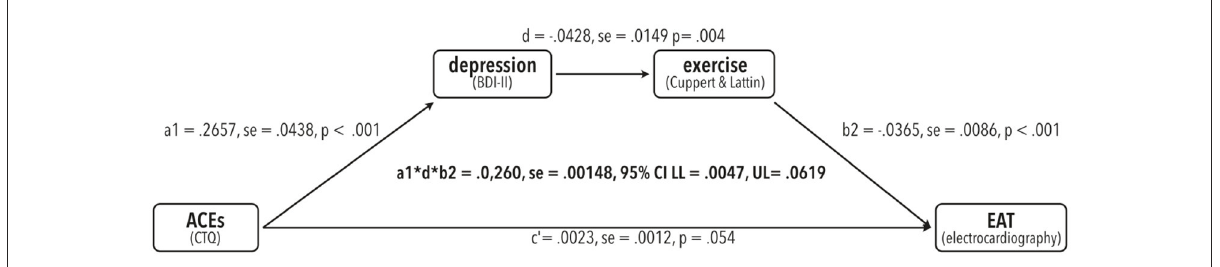
FIGURE2 Results from the testing the serial mediation model (model number 6) proposed in Figure 1 using bias-corrected bootstrapping with 10,000 resamples in PROCESS for R V4.0.1 with a 95% confidence interval (CI). Unstandardized regression coefficients are shown with the corresponding se (standard error) as well as t-values and p -values per path. Indirect effect statistics are shown in the center with completely standardized regression coefficients, se and corresponding lower limits (LL) and upper limits (U).